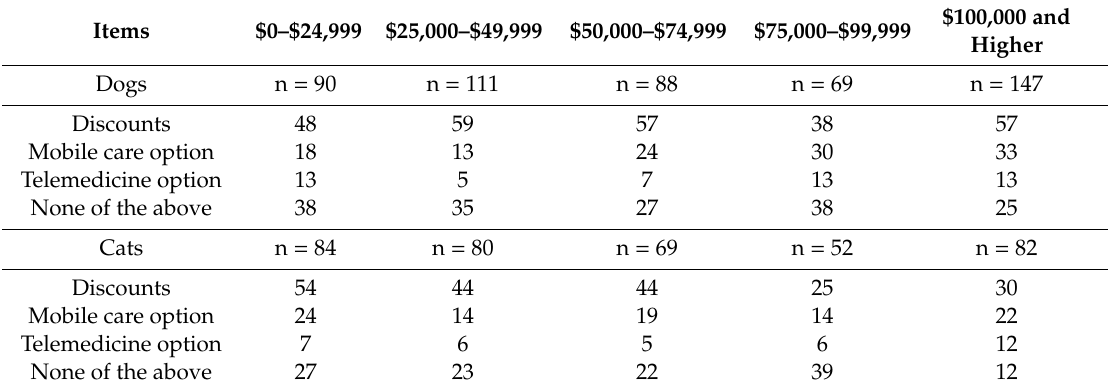
Table A2. What would (would have) incentivize (d) respondents to seek veterinary care, by income.